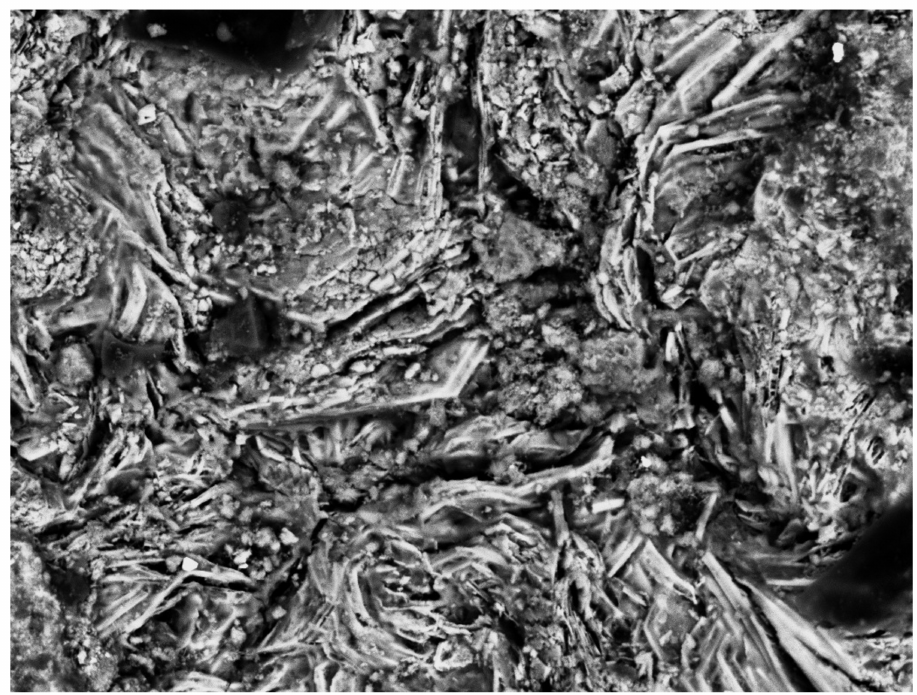
Figure 6. Aggregate of lamellae of the manganite-related Zn,Mn-mineral from Kapova Cave. SEM (BSE) image. Field of view width = 0.15